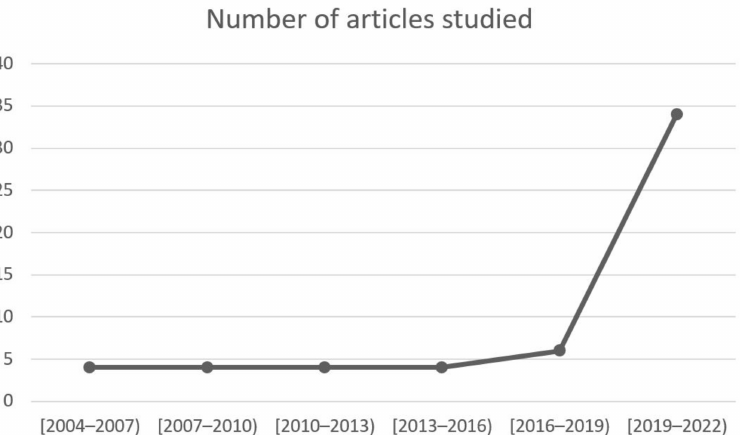
Figure 2. Evolution of the number of studied articles that apply artificial neural networks to refriger- ation